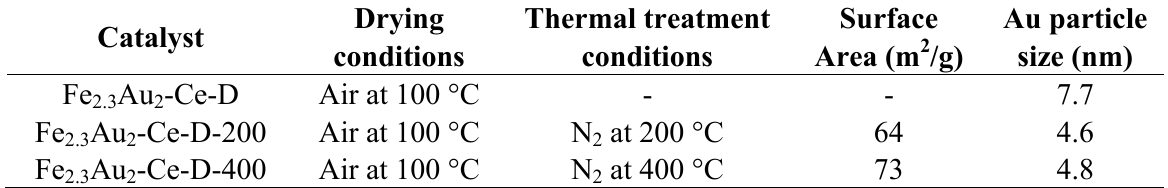
Au -Ce samples depending on thermal 2.3 2